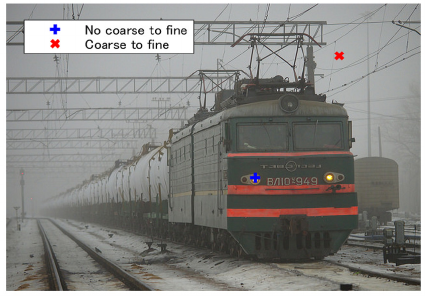
Figure 5. Effectiveness of coarse-to-fine search strategy. Blue ‘ + ’ mark is result of atmospheric-light estimation by pixel-wise dark-channel image without using coarse-to-fine strategy. Red ‘ × ’ is result of pixel-wise dark-channel image using coarse-to-fine strategy.